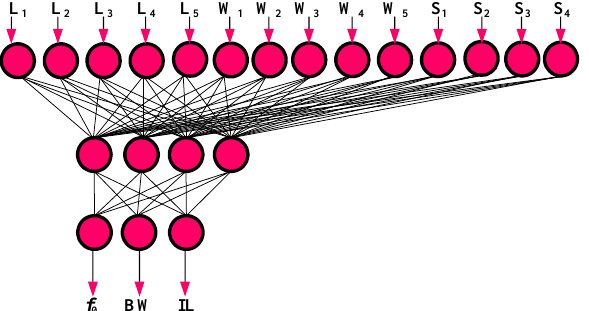
Figure 5. Proposed structure of the ANN model including a single hidden layer with four neurons in the hidden layer. In the presented ANN model, 31 samples are used for the training of the network, while 7 and 2 samples are used for the test and validation of the proposed surrogate model, respectively. In the proposed ANN, mean relative error (MRE) and root mean square error (RMSE) are considered to evaluate the proposed model results as follows.